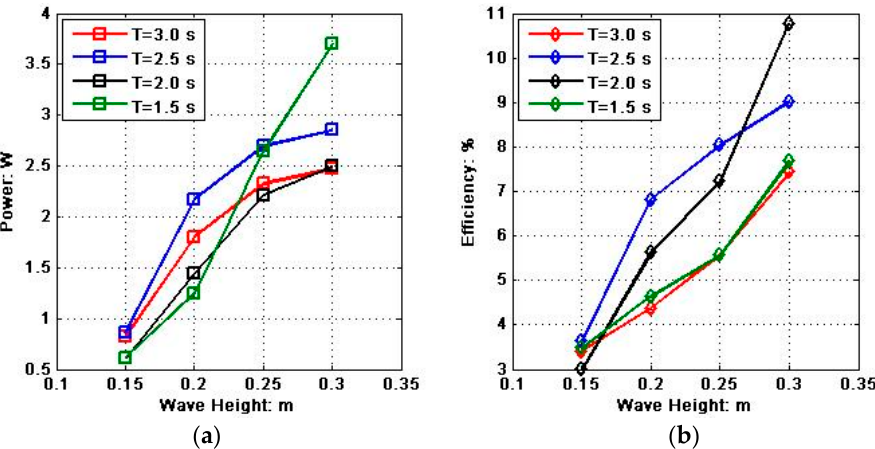
Figure 21. Generation performance of the ACWEC with different significant wave heights, M 1 = 20.11 Figure21. GenerationperformanceoftheACWECwithdifferentsignificantwaveheights, M 1 = 20.11 kg: kg: ( a ) power curve; ( b ) efficiency curve. ( a ) power curve; ( b ) efficiency curve.